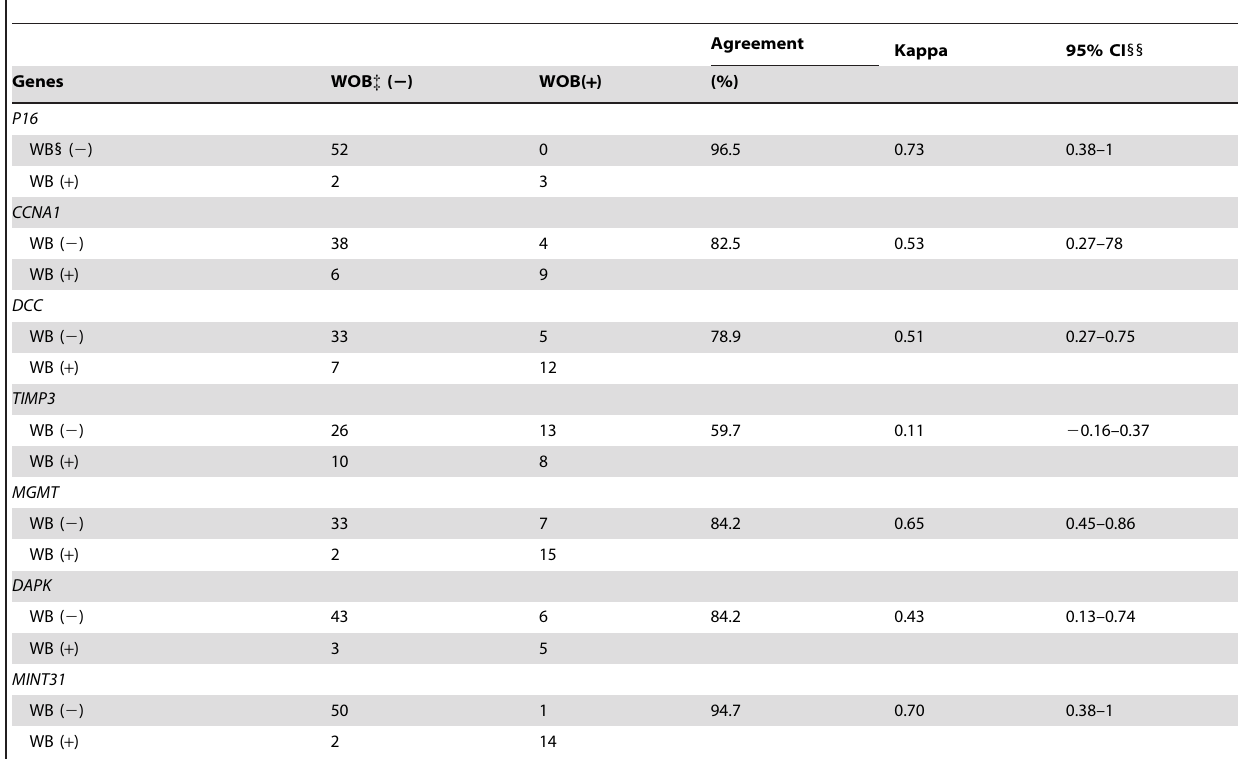
Table 3. Concordance between salivary rinses collected with or without an exfoliating brush from 57 HNSCC patients.